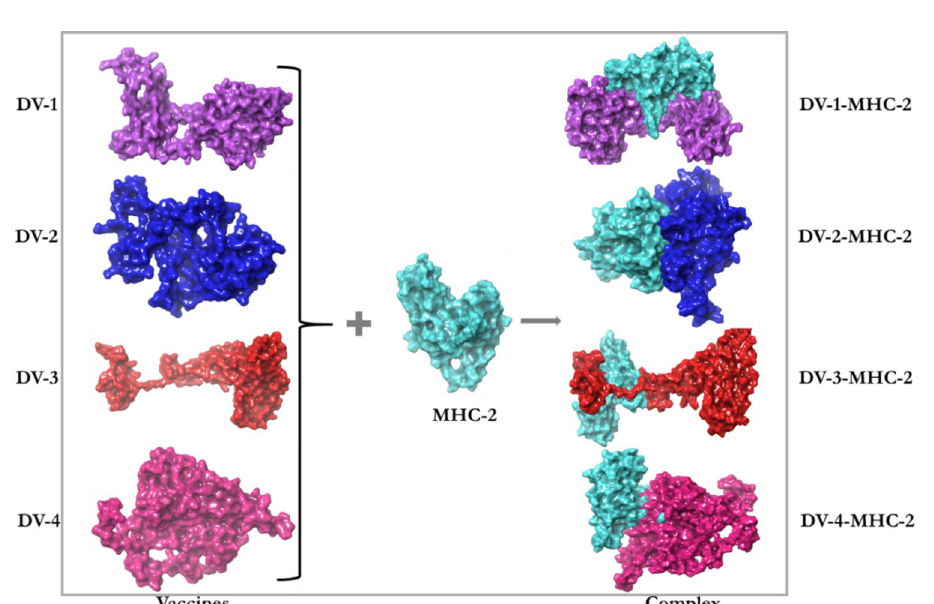
Figure 6. The solid molecular surface display of the predicted vaccines docked to the MHC class-2